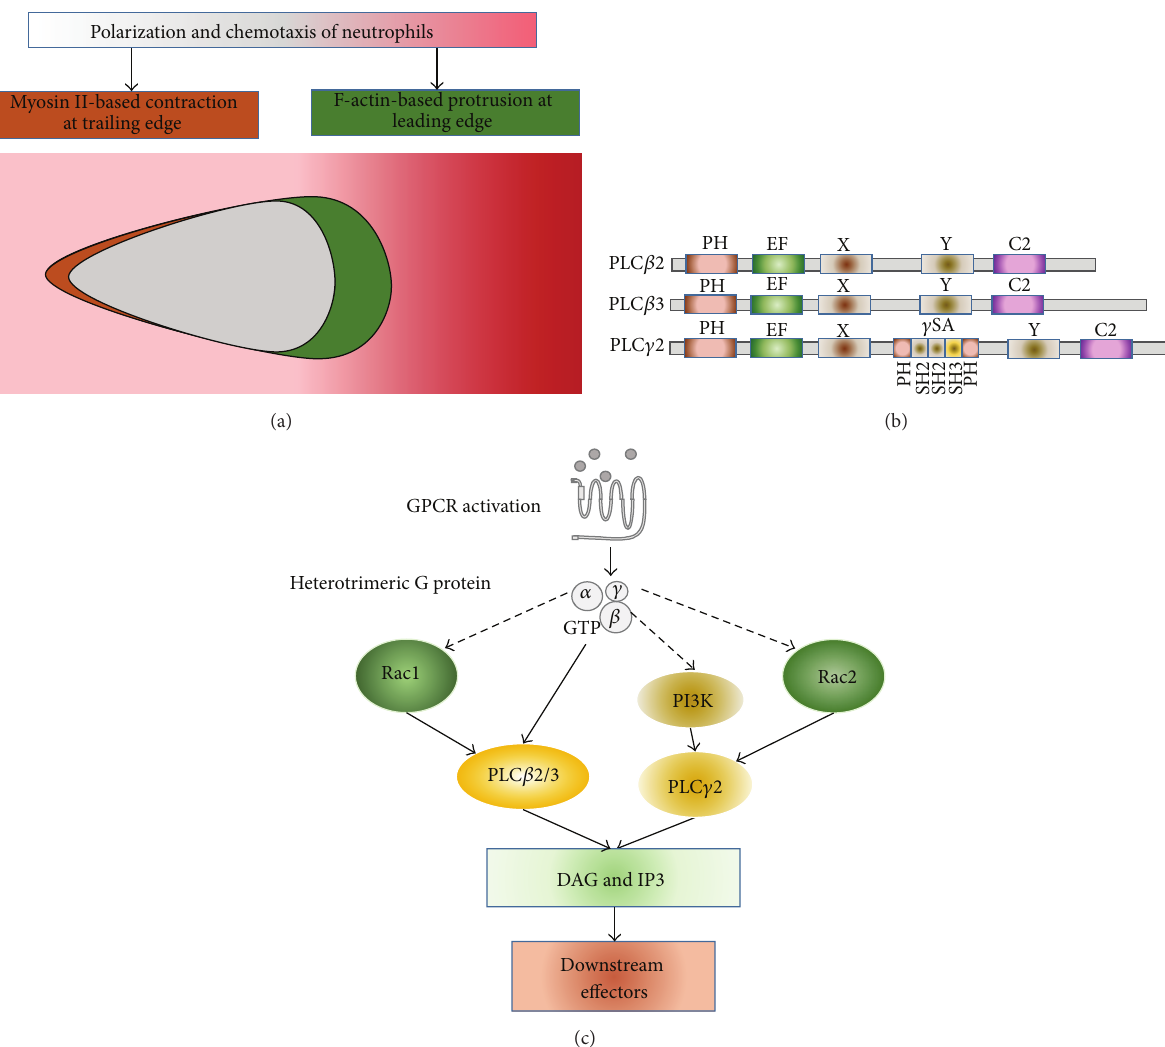
Figure 1: PLC isoforms and their signaling pathways in neutrophils. (a) F-actin-based protrusion in the leading edge and myosin-based contraction in the trailing edge of chemotaxing neutrophil cell. (b) Scheme shows the domain compositions of PLC isoforms expressed in neutrophils. Scheme shows the PH domain, EF-hand motifs, catalytic X and Y domains, and C2 domain in all PLC isoforms. In addition to the domains indicated above, PLC 𝛾 2 is characterized by the insertion of a highly structured region (PLC 𝛾 -specific array, 𝛾 SA), which is comprised of a split PH domain flanking two tandem SH2 domains and an SH3 domain between the two halves of a TIM-barrel catalytic domain. (c) Signaling pathways which activate PLC isoforms in